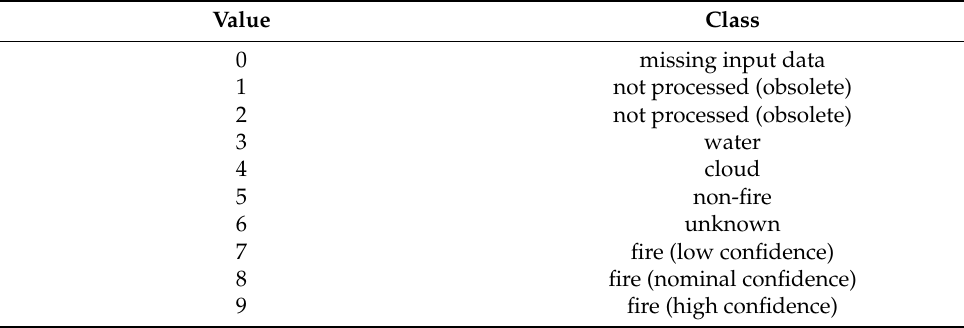
Table 2. MOD14A1 fire-mask classes (Source: LP DAAC).